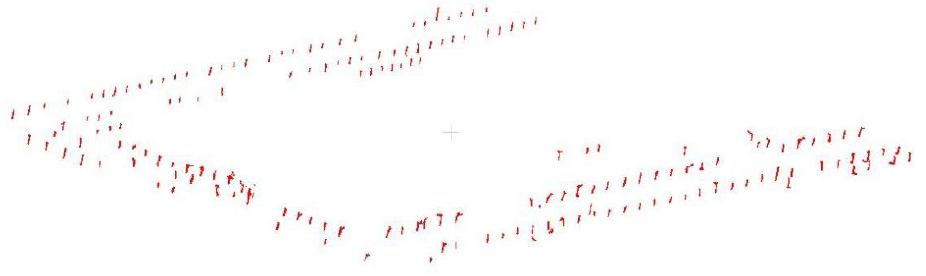
Figure 10. Results of tree trunk extraction in the study area.